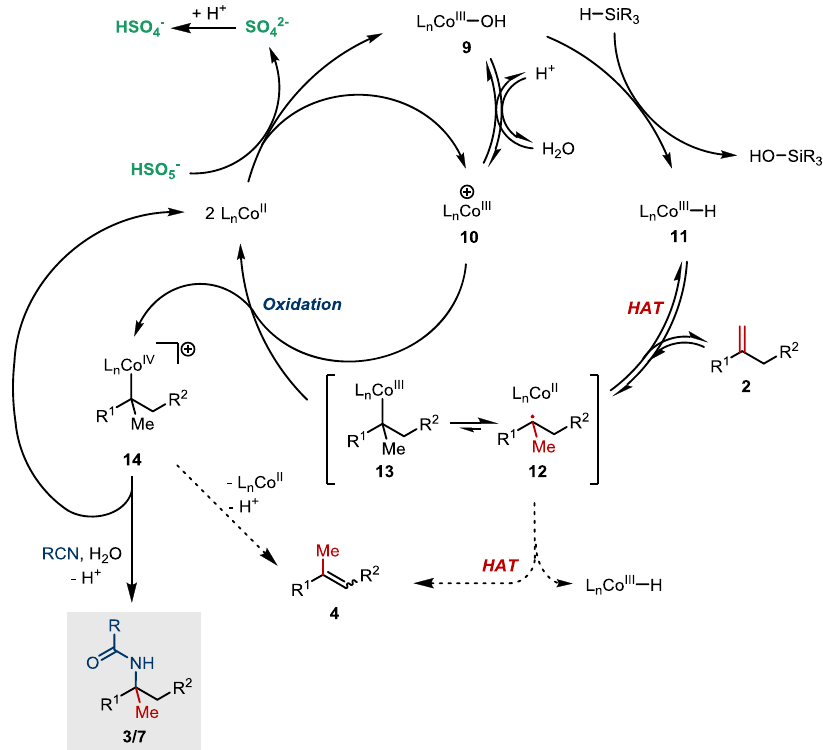
Fig. 6 Proposed catalytic cycle. Organocobalt(IV) species as a carbocation equivalent leads to